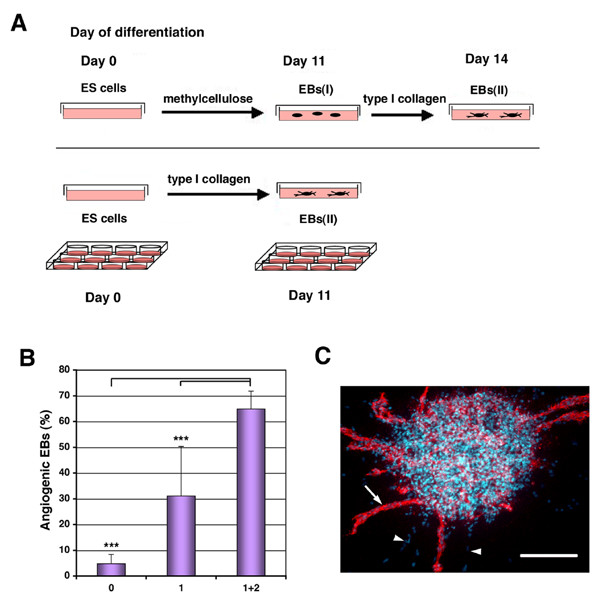
Development of angiogenic embryoid bodies during one-step ES cell differentiation into type I collagen gels. A, Schematic illustration of the one-step method, performed either in 35 mm-diameter plates or in 12-well microplates, compared with the two-step initial angiogenesis model; B, Effect of the addition of angiogenic growth factors (VEGF + FGF2) on the formation of EBs exhibiting endothelial sprouts (angiogenic EBs). ES cell differentiation was performed in the absence (0) or in the presence (1) of angiogenic growth factors added at the initiation of the differentiation of CJ7 ES cells at day 0. (1+2), effect of a second angiogenic growth factor addition at day 6, in addition to day 0, on the formation of sprouting angiogenic EBs. *** p < 0.001; mean values significantly different by unpaired Student's t test. C, CD31 immunostaining of a 11 day-old angiogenic embryoid body derived from CJ7 ES cells obtained in the one-step differentiation method. The arrow points to a CD31-positive endothelial sprout (red staining) and arrowheads to CD31-negative sprouts that only exhibit blue staining of cell nuclei after Hoescht 33258 counterstaining. Scale bar = 200 μm.